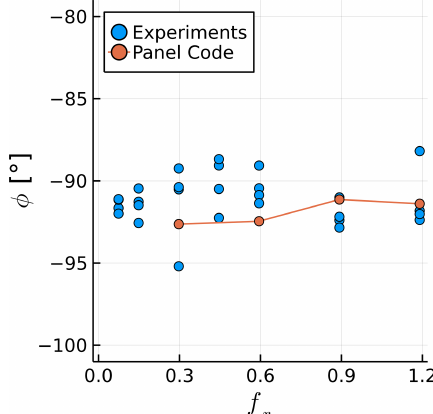
Figure 4. Surge frequency effect on the amplitude of the fluctuation in the thrust coefficient. Simulations at constant A and experiments at various A are shown.